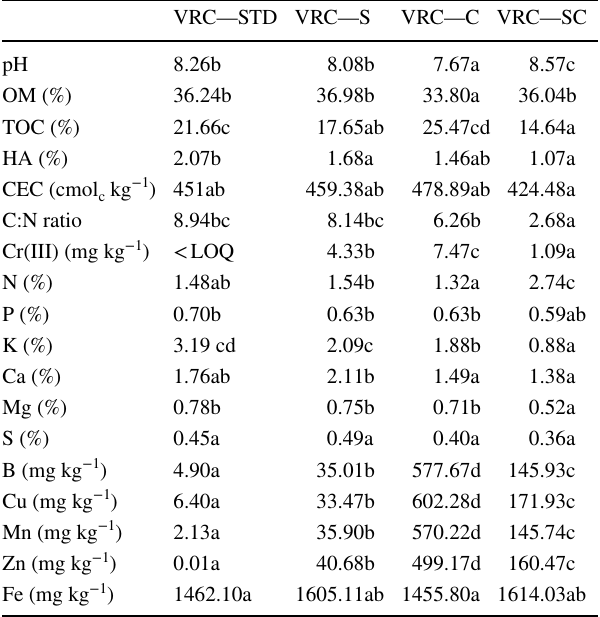
Table 2 Chemical characteristics of the vermicomposted